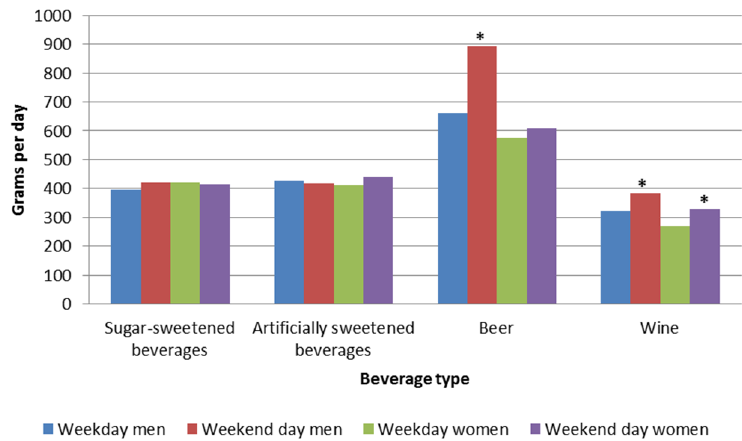
Figure 1. Average consumption in grams of sugar-sweetened beverages ( n = 353 men and 260 women), artificially sweetened beverages ( n = 191 men and 242 women), beer ( n = 182 men and 85 women), and wine ( n = 156 men and 204 women) among consumers of the selected beverage types on weekdays and weekend days. * p < 0.05 for difference between weekdays and weekend days. Tested with mixed models.